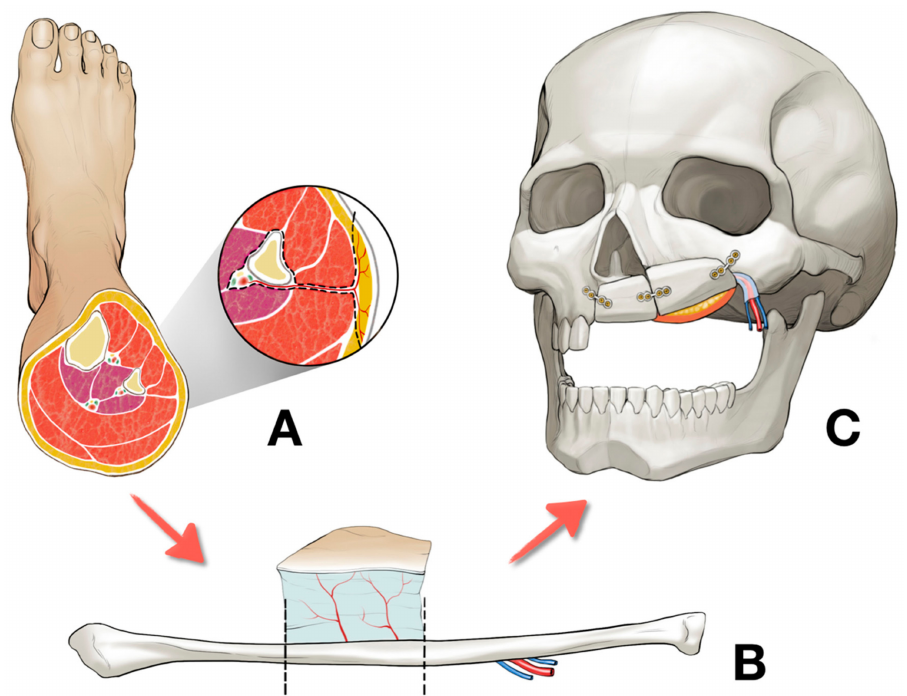
Figure 3. The entire procedure of the left palatomaxillary defect reconstruction using right fibula free flap: ( A ) Harvesting the right fibula free flap, ( B ) osteotomized into two segments, and ( C ) placement of the fibula free flap at the left palatomaxillary area.